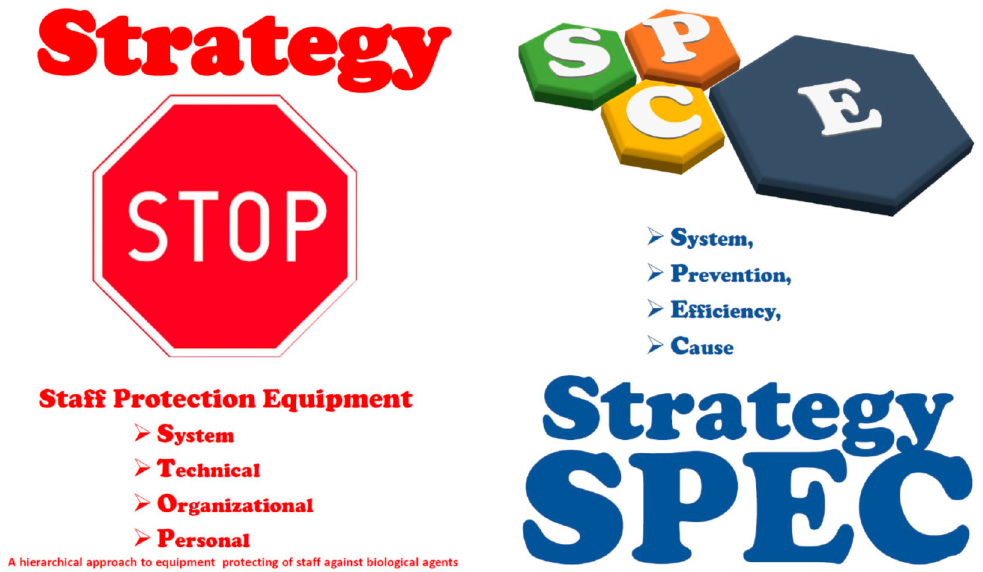
Figure 7. Comparison of the basic assumptions of the conservative STOP strategy and the offensive SPEC strategy.